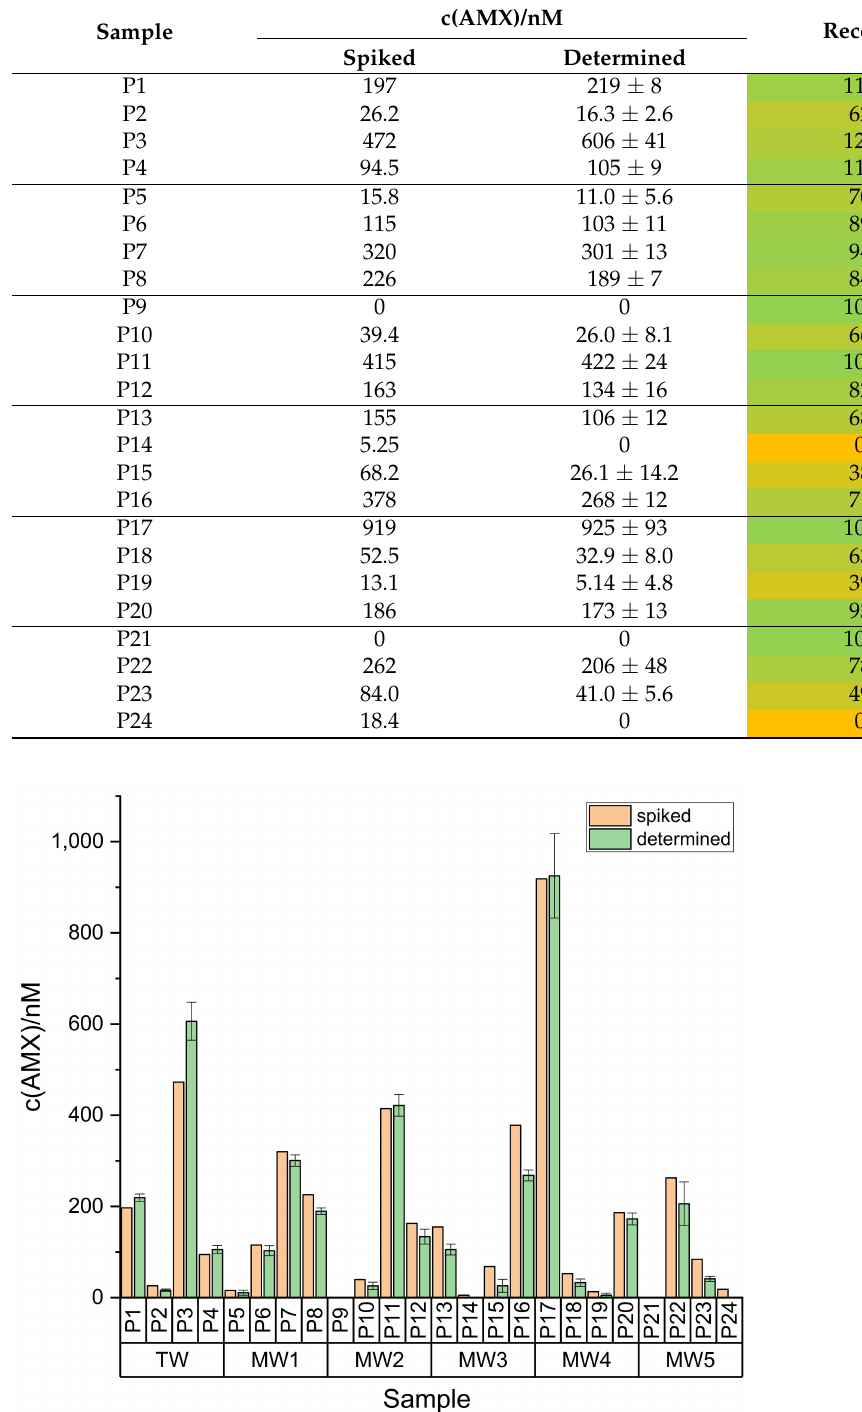
Figure 6. Comparison of spiked and determined concentrations of AMX in water samples. For details on sample parameters, see Supplementary Table